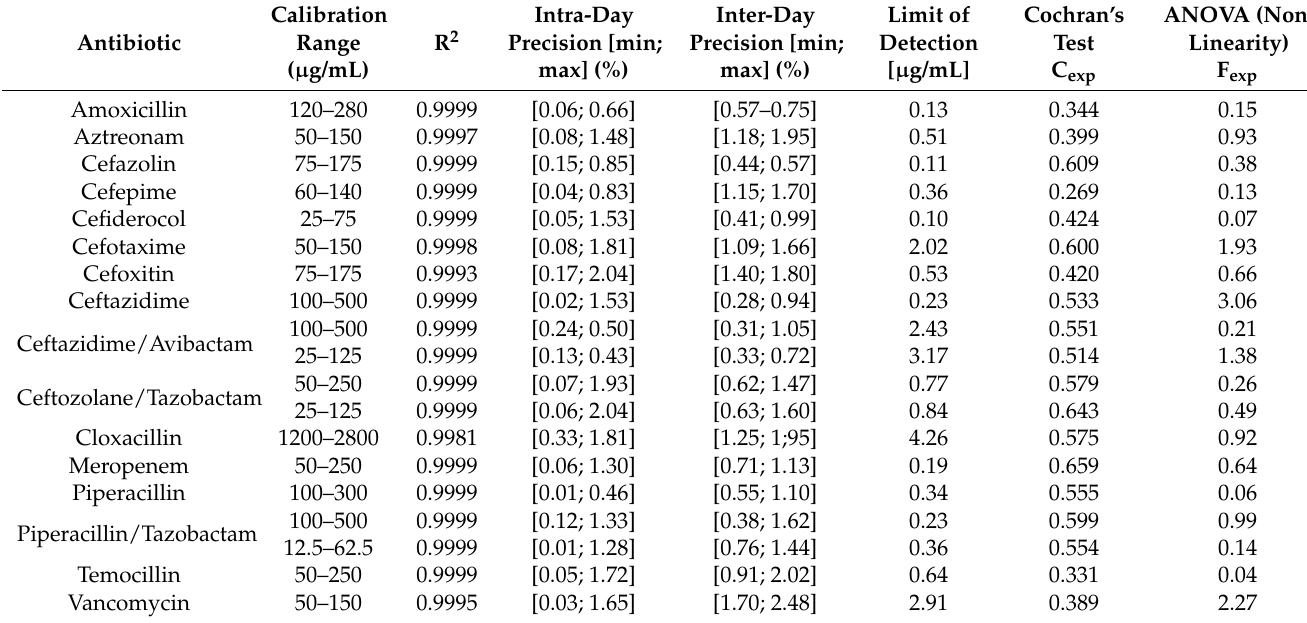
Table 1. Validation criteria for analytical HPLC